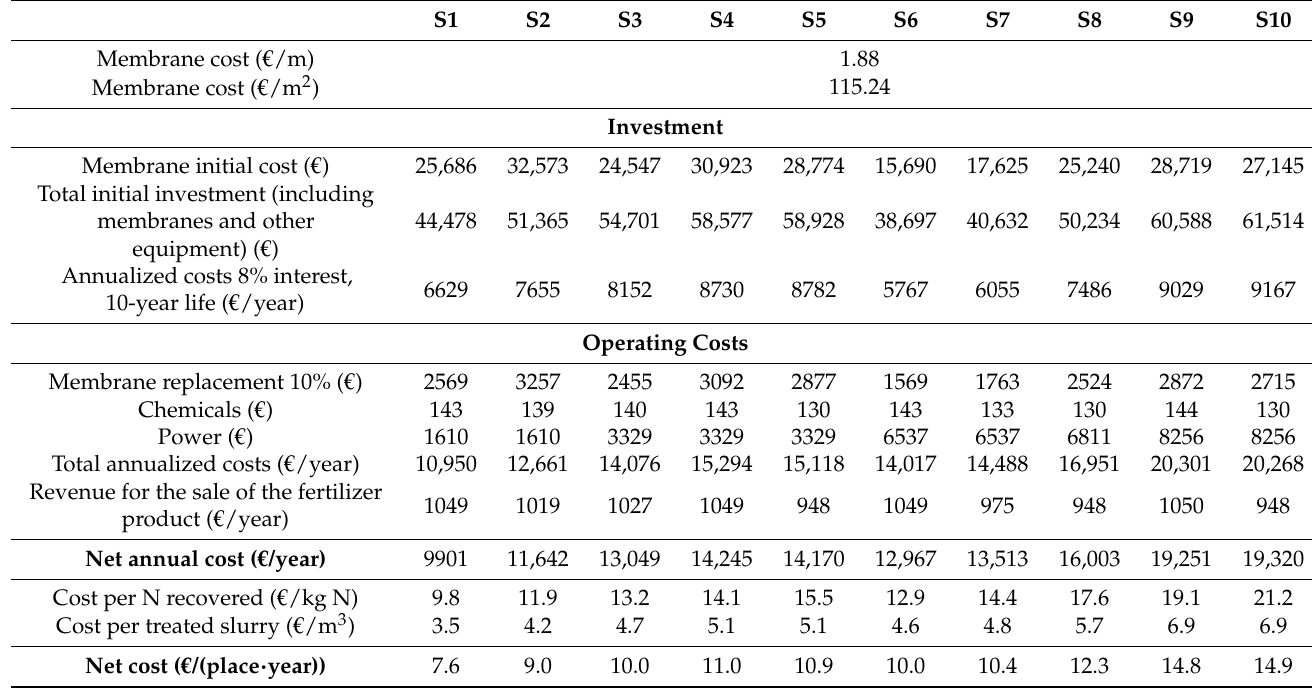
Table 2. Summary of investment and operating costs and revenues for each gas-permeable membrane